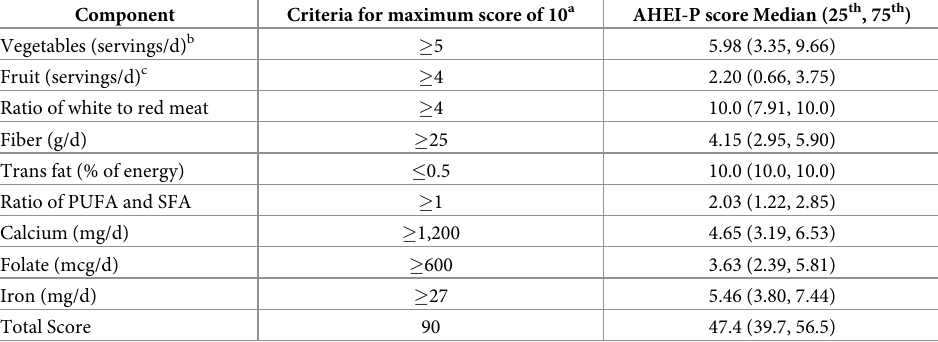
Total Score 47.4 (39.7, 56.5) AHEI-P, Alternate Healthy Eating Index for Pregnancy; PUFA, Polyunsaturated Fatty Acid; SFA, Saturated Fatty Acids. a Scored intermediate intake proportionately 0 and